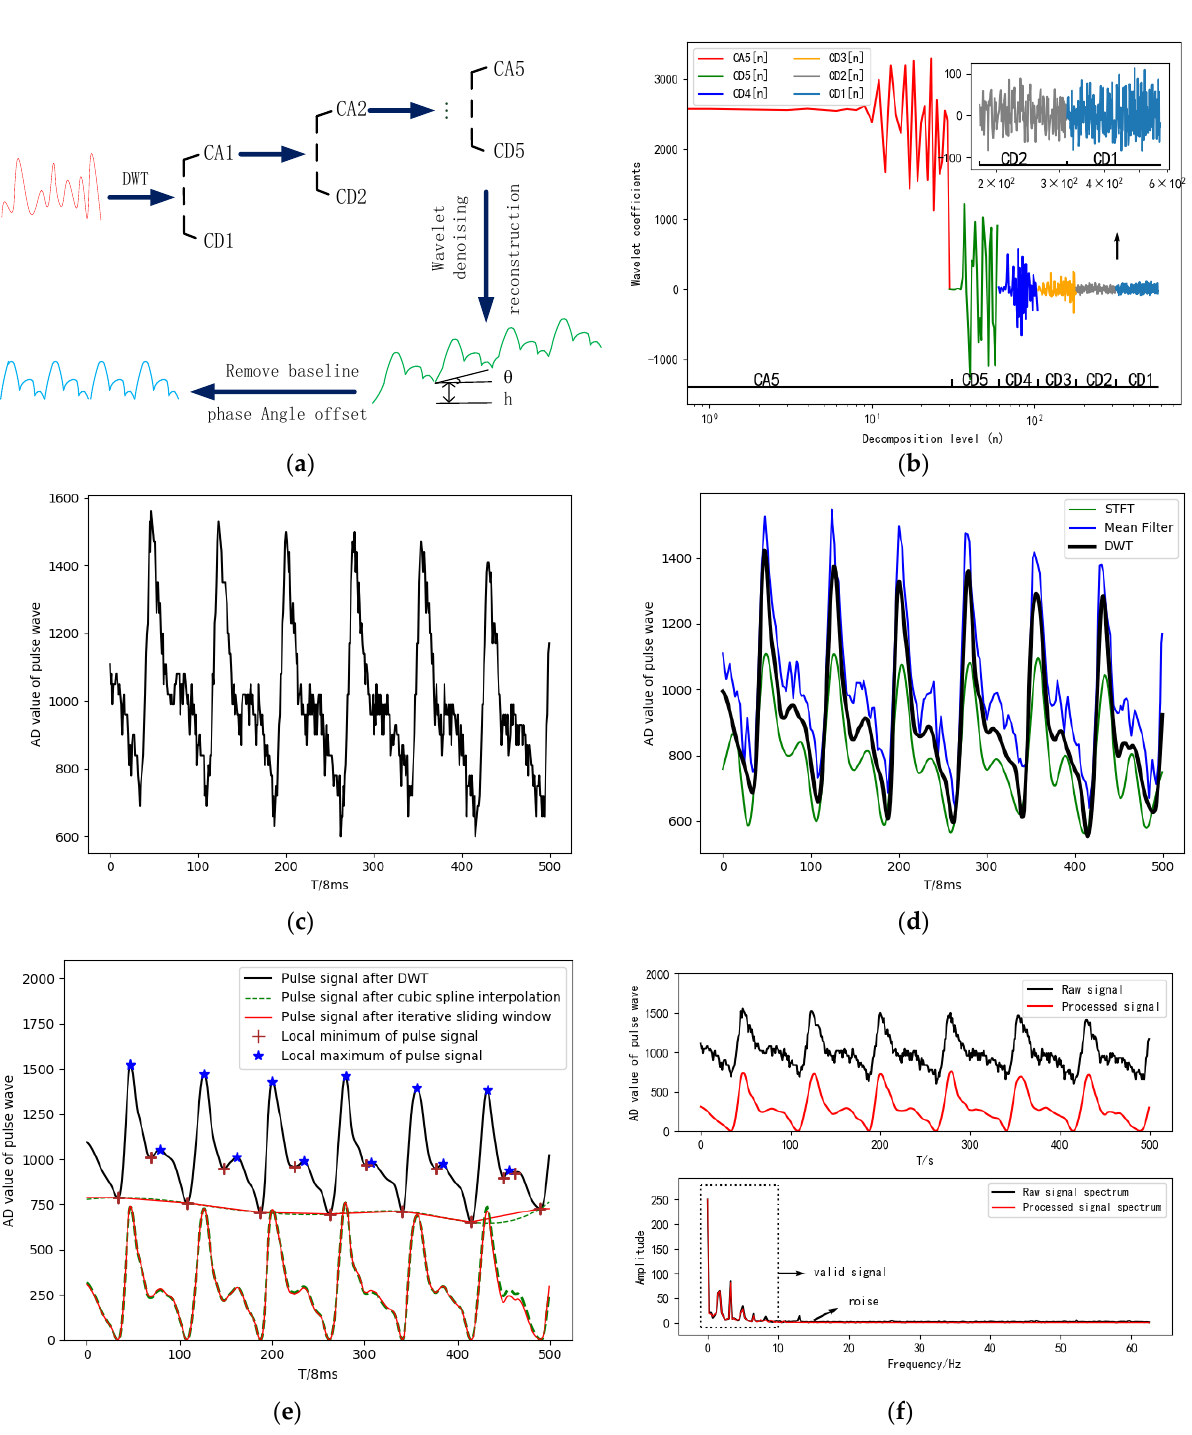
Figure 5. Wavelet transform and iterative sliding window processing of the pulse signal. ( a ) The pulse signal preprocessing flow; ( b ) Wavelet decomposition of the pulse signal; ( c ) Raw signal; ( d ) Hardware circuits noise removal; ( e ) The baseline and the phase angle offset removal; ( f ) Amplitude-frequency characteristics of the pulse signal.